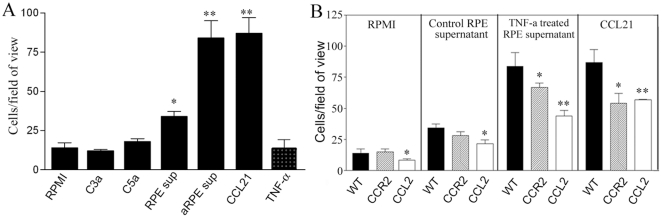
Chemotaxis of bone marrow-derived dendritic cells (BMDCs).A, migration of BMDCs of WT mice in response to different stimuli. *, P<0.05, **, P<0.01 in comparison to RPMI. Mean ± SEM, n = 3, Unpaired Student t test. B, the migration of BMDCs of different strains of mice in response to RPMI, RPE supernatant, TNF-a treated RPE supernatant and chemokine CCL21. *, P<0.05, **, P<0.01 in comparison to WT cells. Mean ± SEM, n = 3, Unpaired Student t test. Experiments were repeated twice.